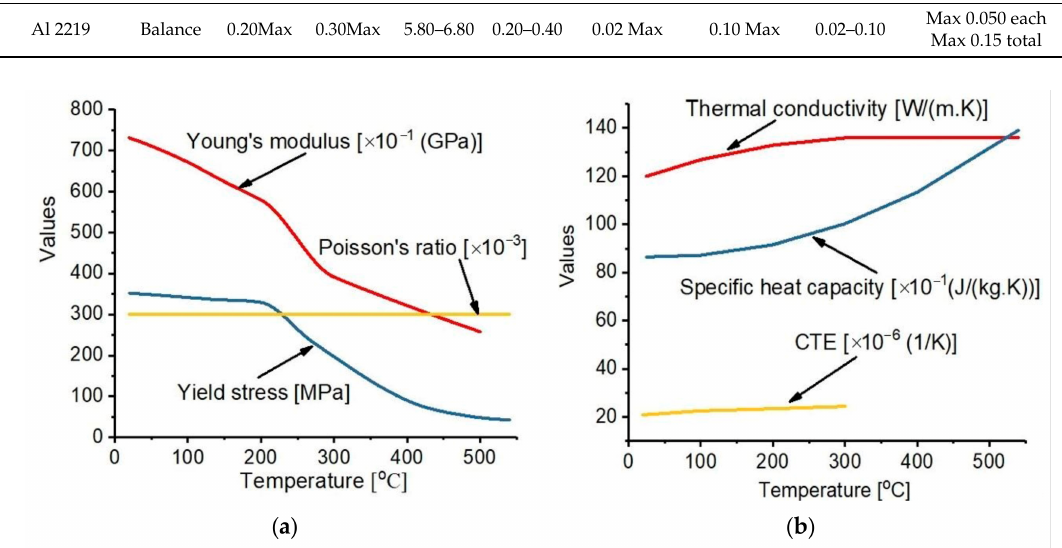
Figure 1. Properties of Al 2219 ( a ) mechanical properties ( b ) thermal